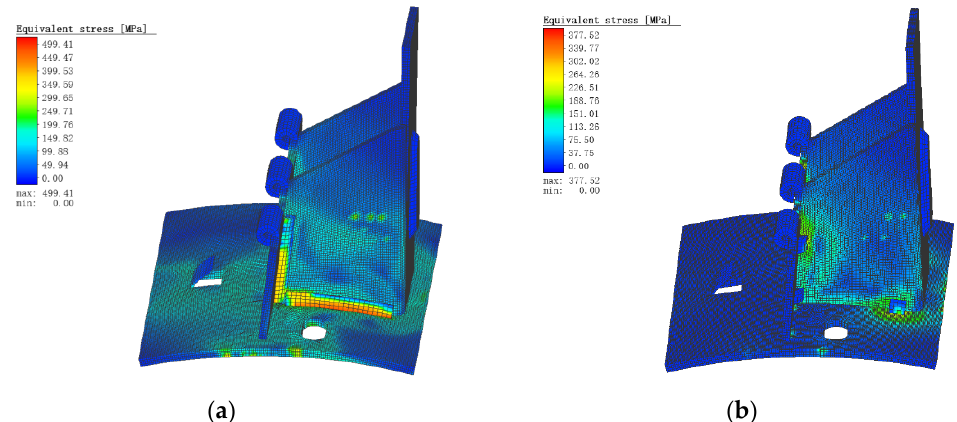
Figure 8. Equivalent stress diagram under continuous welding and spot welding. ( a ) Continuous welding; ( b ) spot welding.